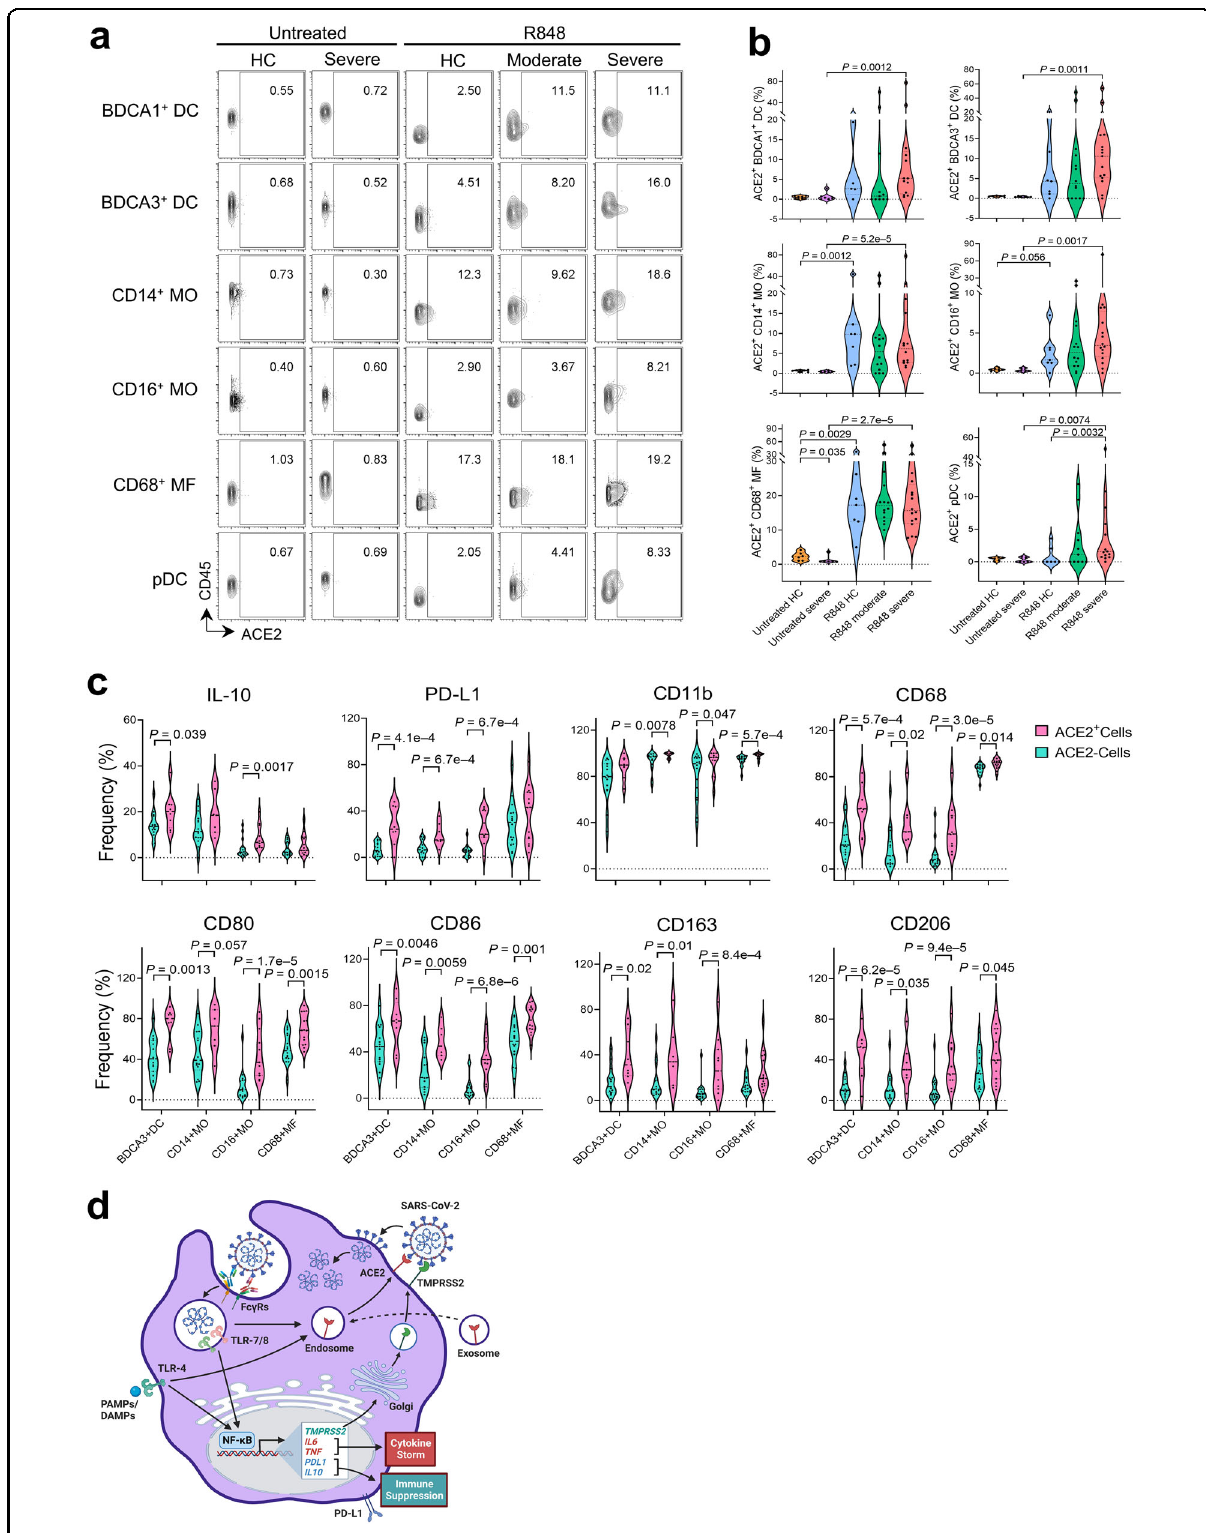
Fig. 6 (See legend on next